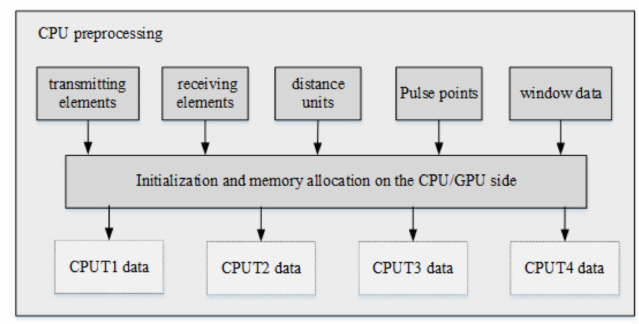
Figure 6. Flow chart of preprocessing on